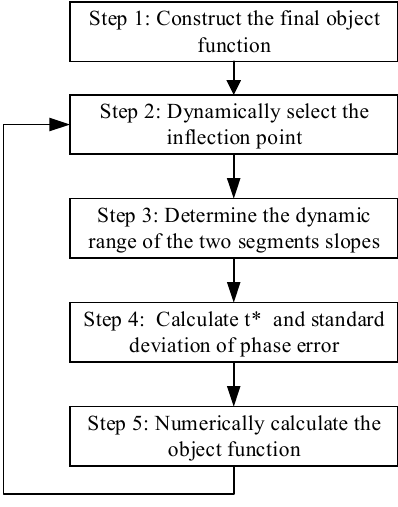
Figure 7. Flow chart of the